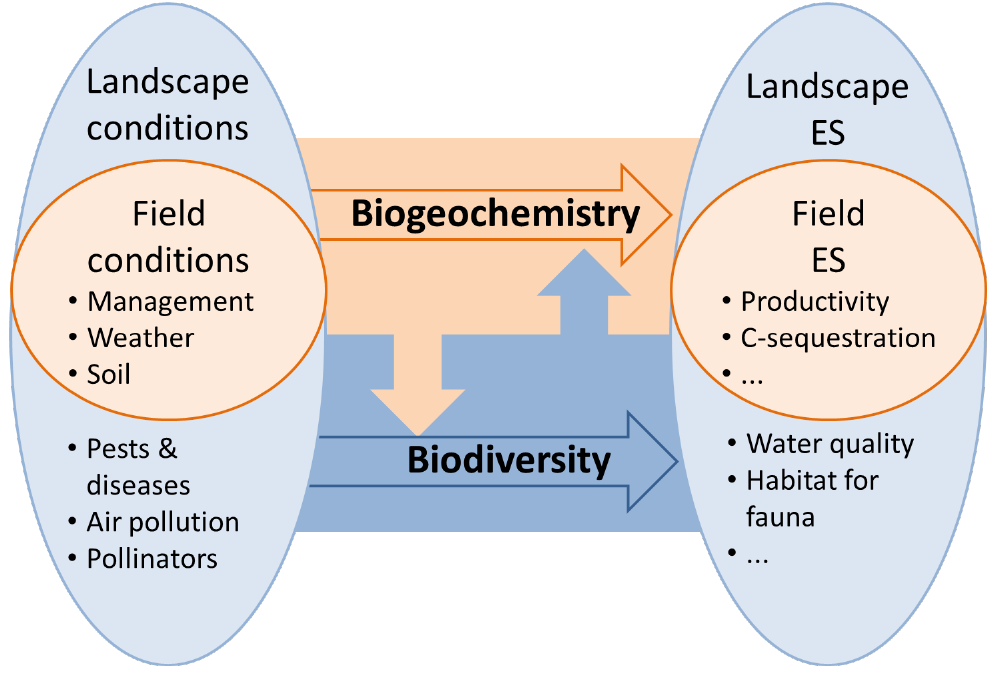
Figure 5. Biogeochemistry and biodiversity at field and landscape scale, with scale-dependent environmental drivers and provision of ecosystem services (ES).